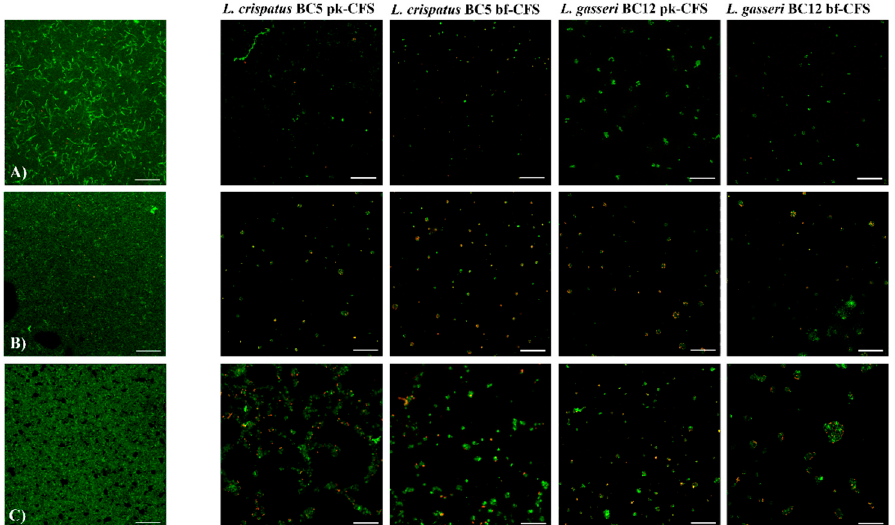
Figure 4. Confocal microscopy analysis of Candida biofilm treated with pk-CFS and bf-CFS from L. crispatus BC5 and L. gasseri BC12 (second—fifth columns). Biofilms were stained using two fluorescent dyes: thiazole orange (viable cells, green) and Live-or-Dye™ (dead cells, red). ( A ) C. albicans SO1 biofilm; ( B ) C. lusitaniae SO22 biofilm; ( C ) C. tropicalis SO24 biofilm. Scale bar = 100 μ m.